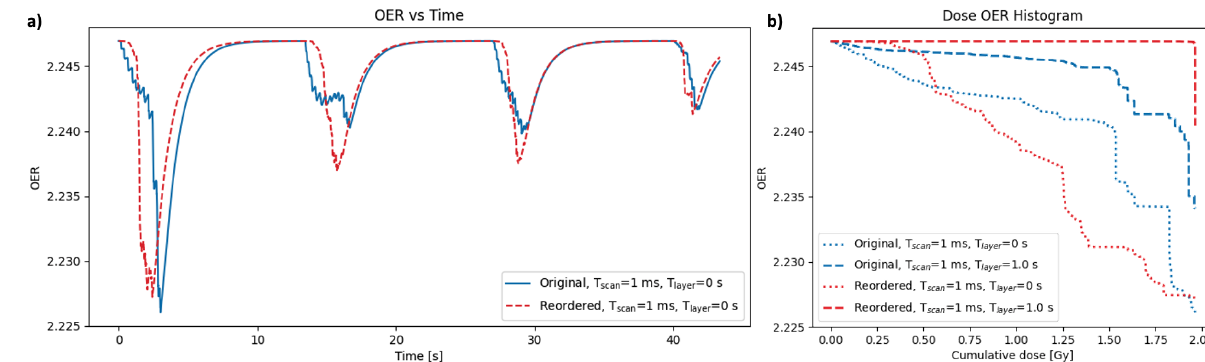
Figure 7. ( a ) OER as a function of time for a single point in the GTV for the base of skull plan (point a in Figure 3). The OER profile is shown for two different methods of delivering the same set of spots: original results (blue) were generated by scanning spots layer-by-layer; reordered results (red) were generated by scanning all spots row-by-row in the x - y plane regardless of energy layer. ( b ) Dose-OER histograms for the original (blue) and reordered (red) orders of delivery, using different values of the time taken to scan between consecutive spots, T scan , and the time taken to change energy layer, T layer . All results were generated for the node 25µm from the capillary. Note that the overall dose distribution in each case is identical, as it is only the temporal delivery that is